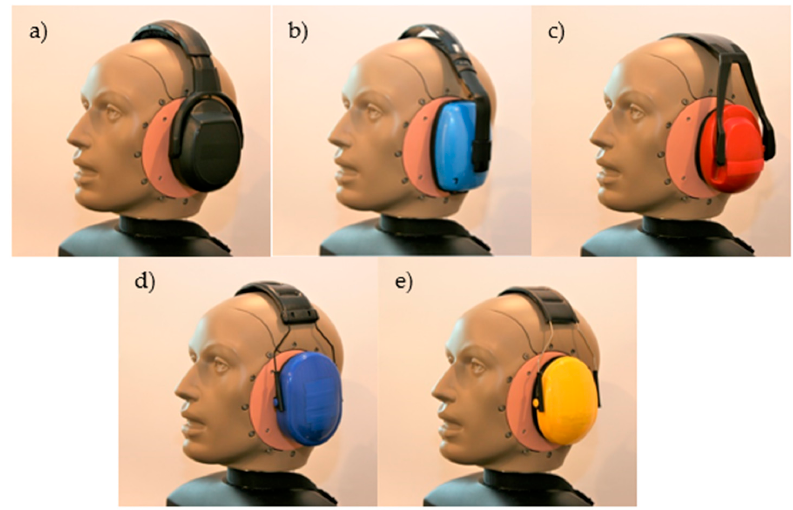
Figure 1. Tested earmuffs (EM): ( a ) EM1, ( b ) EM2, ( c ) EM3, ( d ) EM4, and ( e ) EM5.